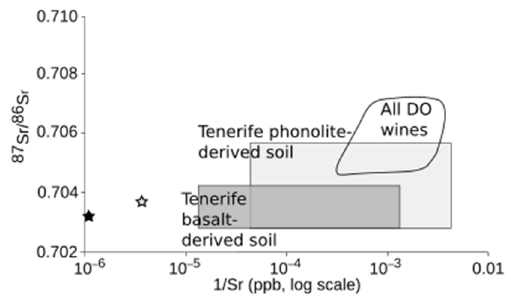
Figure 6. The relationship between Tenerife bedrocks, hypothetical soils derived from these and wines from the five Tenerife DO regions. Local basalt (black star; n = 110) and phonolite (white star; n = 37) averages from the GEOROC database [28], and Sr concentration range assigned by a typical derivation factor from the rock parent [23] (note the logarithmic scale, necessary to display both rocks and wines).